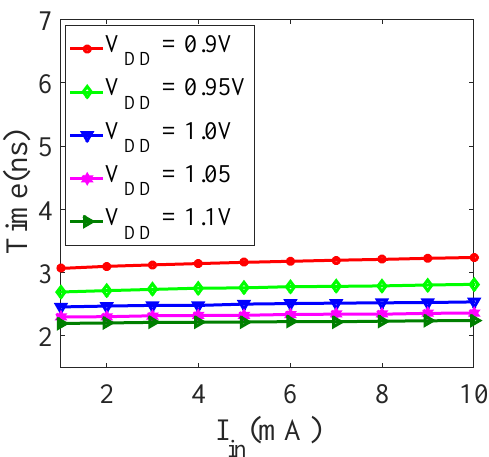
Figure 11. Simulated output delay vs. supply voltage ( V DD